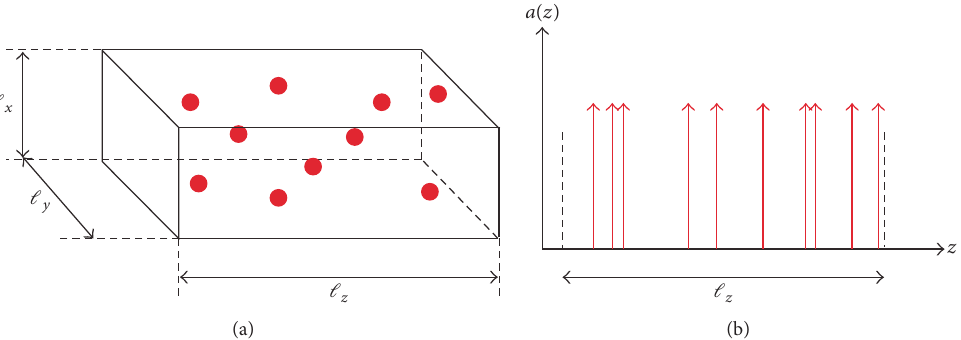
Figure 8: Schematic overview of the conversion of the three-dimensional distribution of particles (a) to a one-dimensional distribution in depth